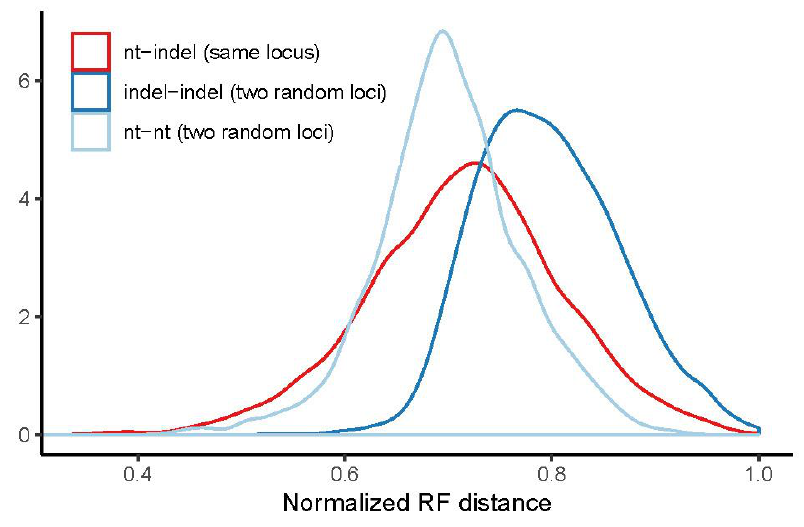
Figure 6. RF distances for intron gene trees. Density of normalized RF distances between indel and nt gene trees of the same locus (red) are compared to distances between randomly sampled indel gene trees and randomly sampled nt gene trees. Randomly sampled nt gene trees are slightly more congruent with one another than indel and nt gene trees of the same locus. Indel and nt gene trees of the same locus are substantially more congruent with one another than randomly sampled indel gene trees. Similar patterns are observed for UCE gene trees (Figure S9).